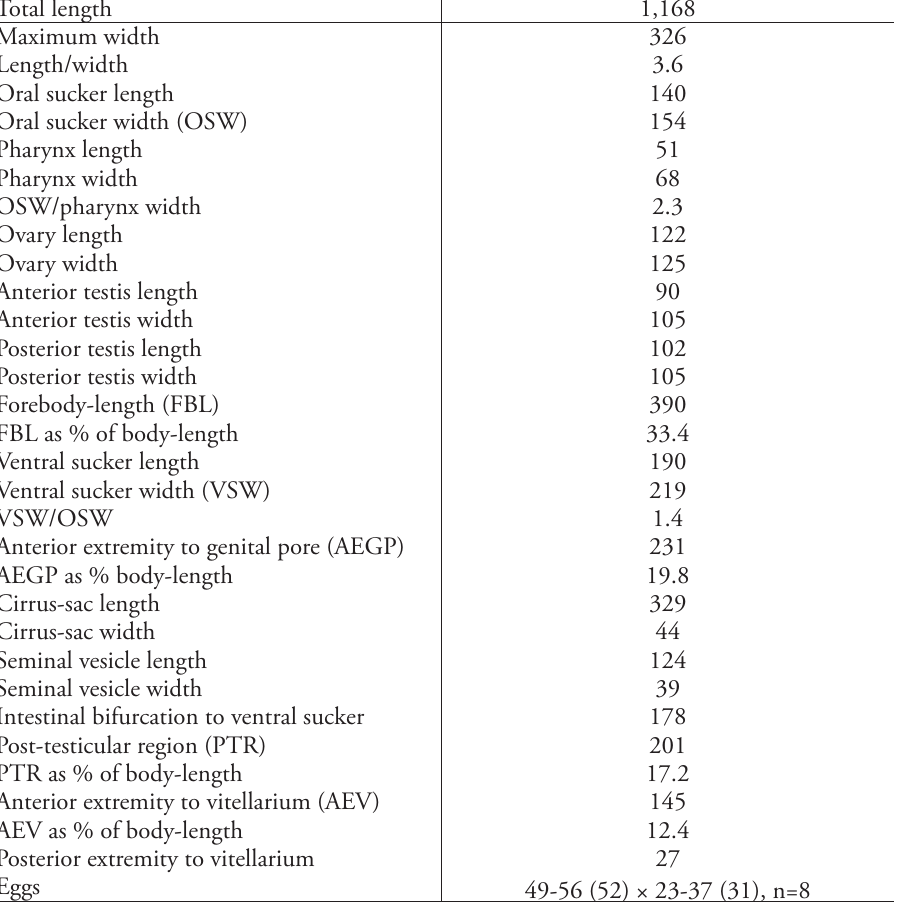
Table 3. Measurements (in μm) of Macvicaria dextrocaula n. sp. (n = 1) from Notolabrus fucicola , Off American River, South Australia Total length 1,168